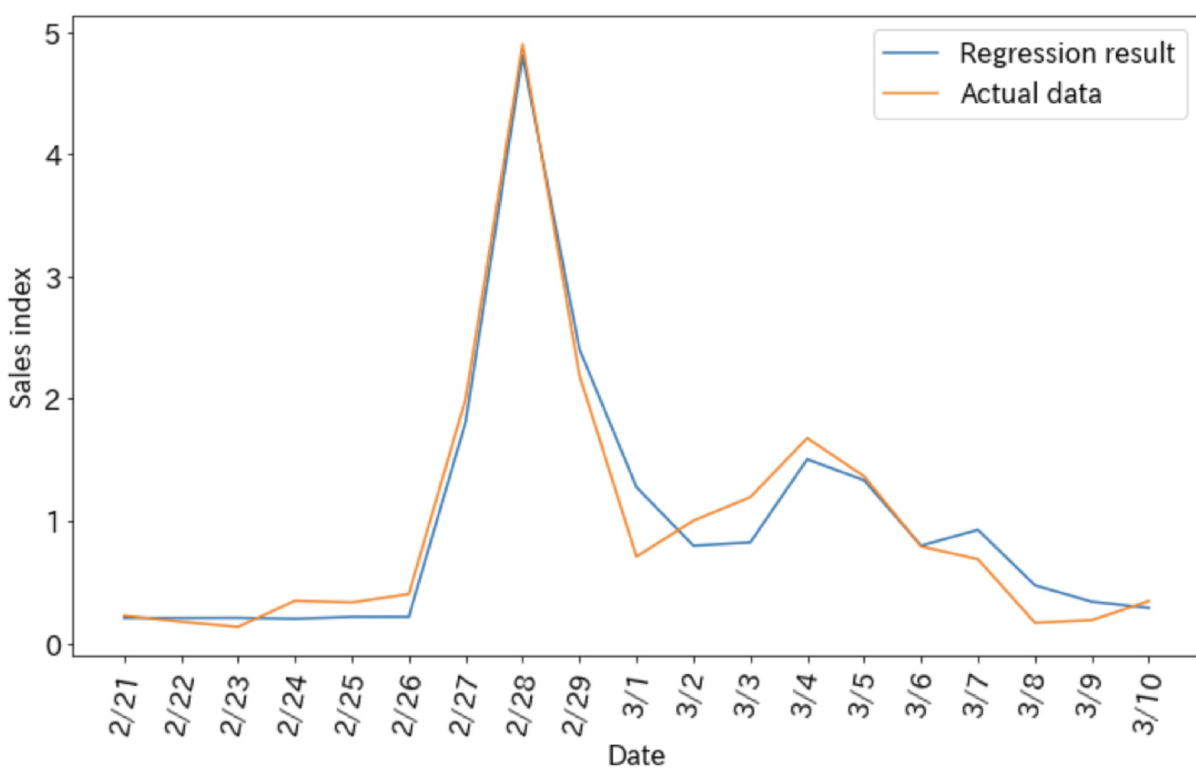
Fig 4. Regression results.